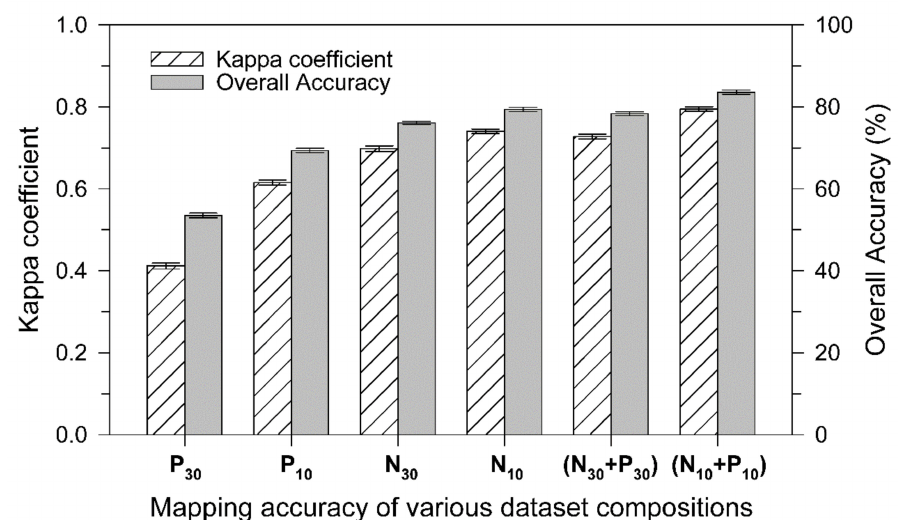
Figure 7. The kappa coe ffi cient and overall accuracy of forest tree species identification based on di ff erent time series NDVI images, phenological metrics and di ff erent schemes of combinations of NDVI and phenological metrics. The P 30 and P 10 indicates phenological metrics obtained from 30-day and 10-day images, and N 30 and N 10 stand for time series of 30-day and 10-day NDVI time series respectively.